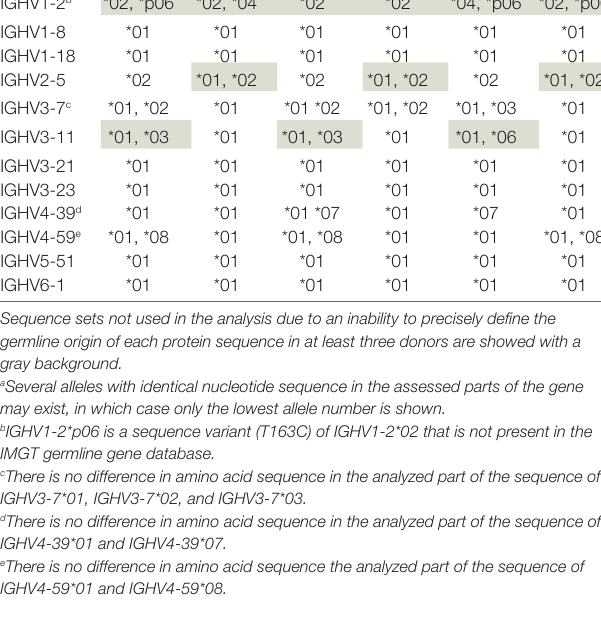
Table 1 | Examples of germline gene allele repertoire of the six lymphocyte donors as assessed using the IgM-encoding transcriptome. germline allele composition of each donor a